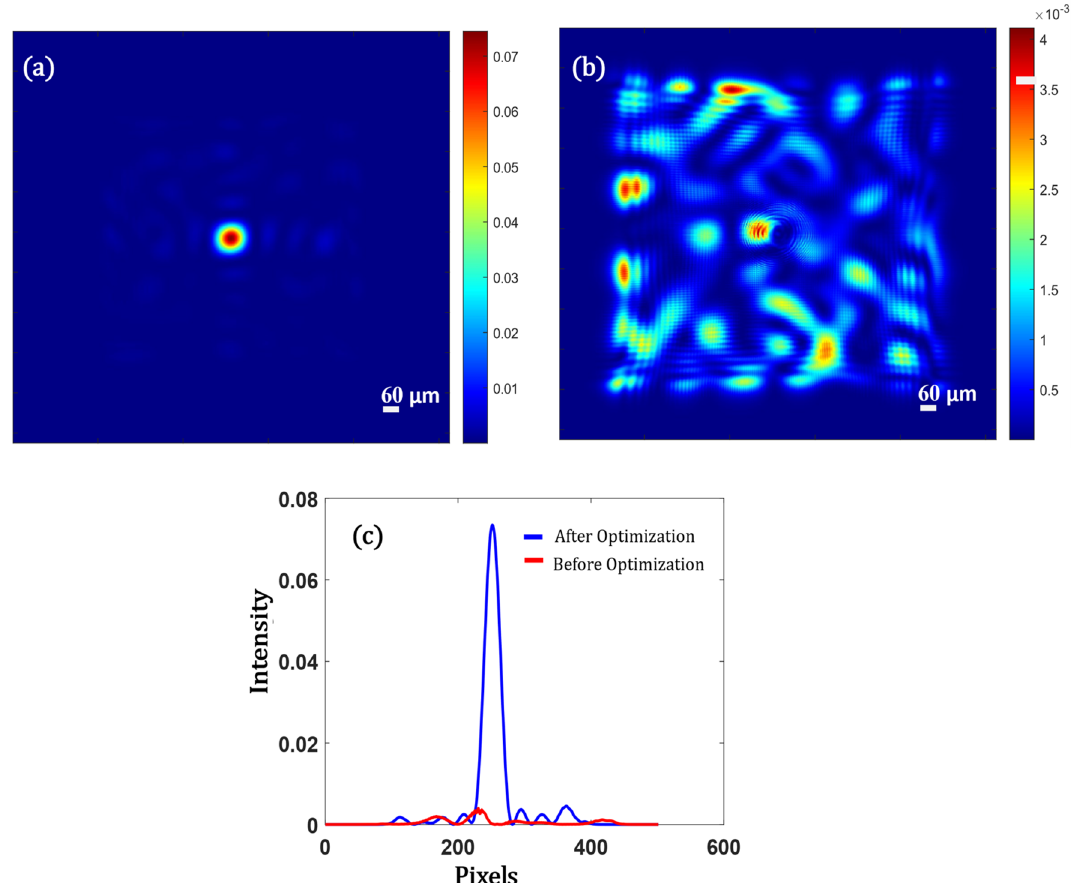
Figure 2. Simulation Results showing ( a ) The focus obtained after optimization when the diffuser is illuminated with the correct phase mask that cancels the diffuser to obtain a strong focus non-invasively. ( b ) Scattered Speckle pattern on the last plane of the diffuser when it is illuminated with a plane wave, ( c ) Intensity profile along an axis for both ( a ) and ( b ) marked in blue and red